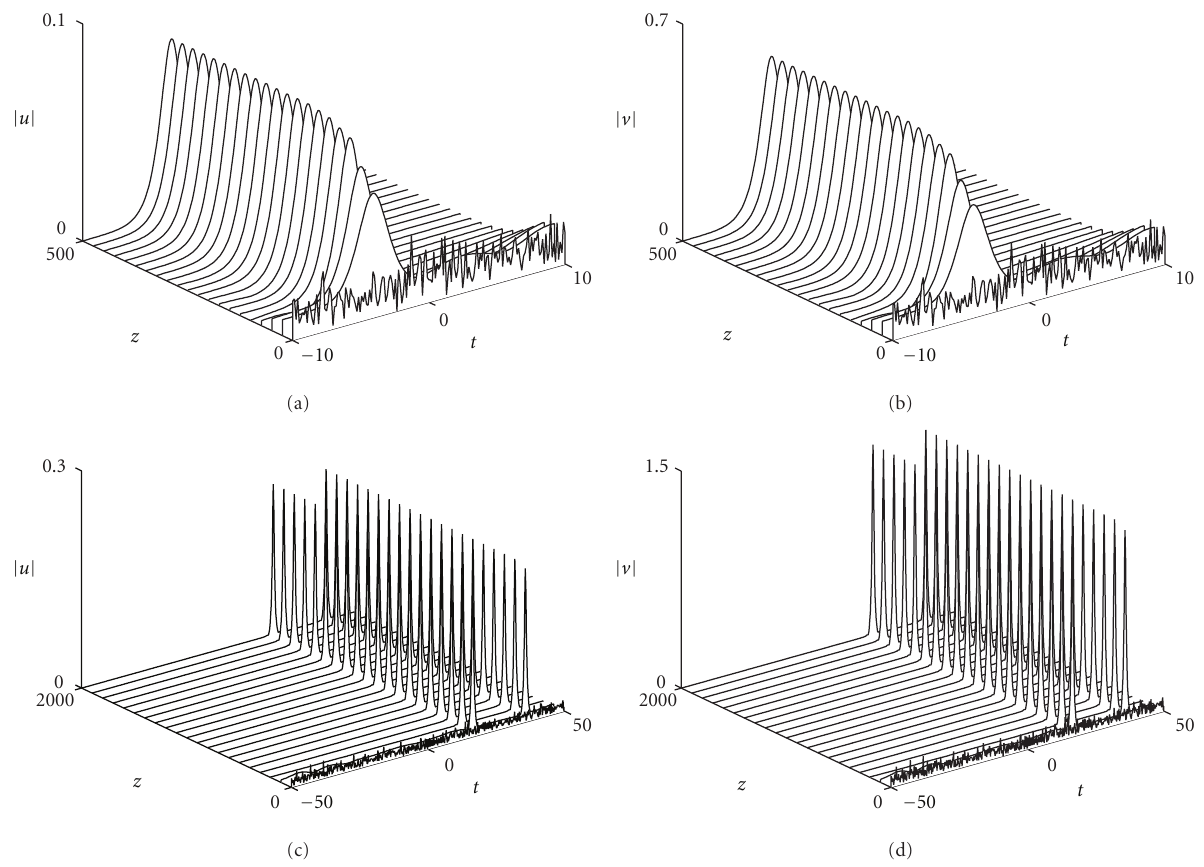
Figure 2: Self-starting mode-locking from white noise. (a) and (b) Stable single-pulse mode-locking when g 0 = 1. (c) and (d) Stable double- pulse mode-locking when g 0 = 2 . 7. The rest of the parameters are D = 0 . 4, K = 0 . 1, e 0 = 1, τ = 0 . 1, Γ = 0 . 1, α 1 = 0, α 2 = 0 . 82 π , α 3 = 0 . 1 π , and α p = 0 . 45 π